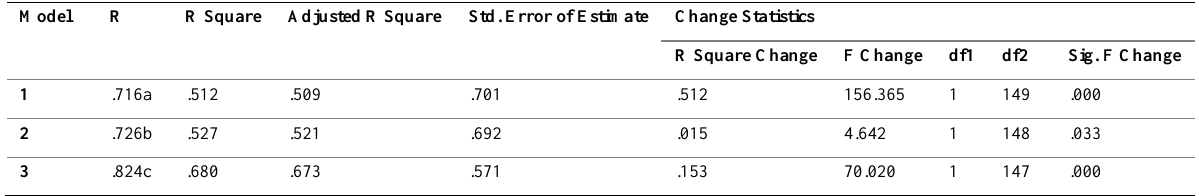
Table 8: Model Summary/ Technological Innovation, Service Quality and performance